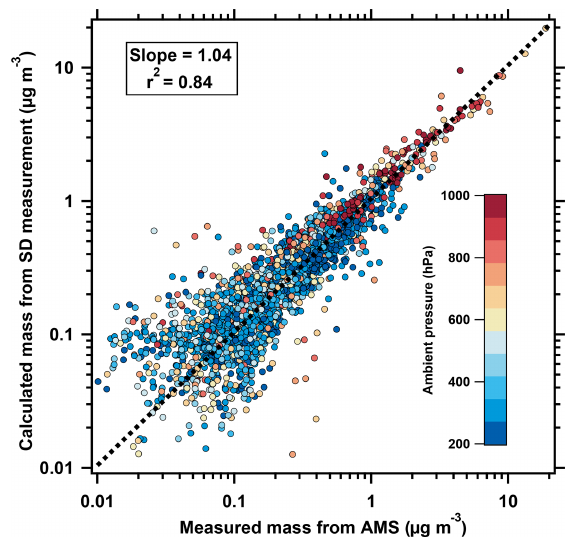
Figure 11. Dry aerosol mass calculated by integrating the parti- cle size distributions measured by the NMASS, UHSAS, and LAS instruments and applying the density and AMS aerodynamic lens transmission efficiency calculated as described in the text as a func- tion of the aerosol mass measured by the AMS and SP2 instruments. Data are 1min averages from the entire ATom-1 campaign. Line and slope are from a two-sided linear least-squares regression forced through zero intercept. Value of r 2 is from a one-sided linear least- squares regression.